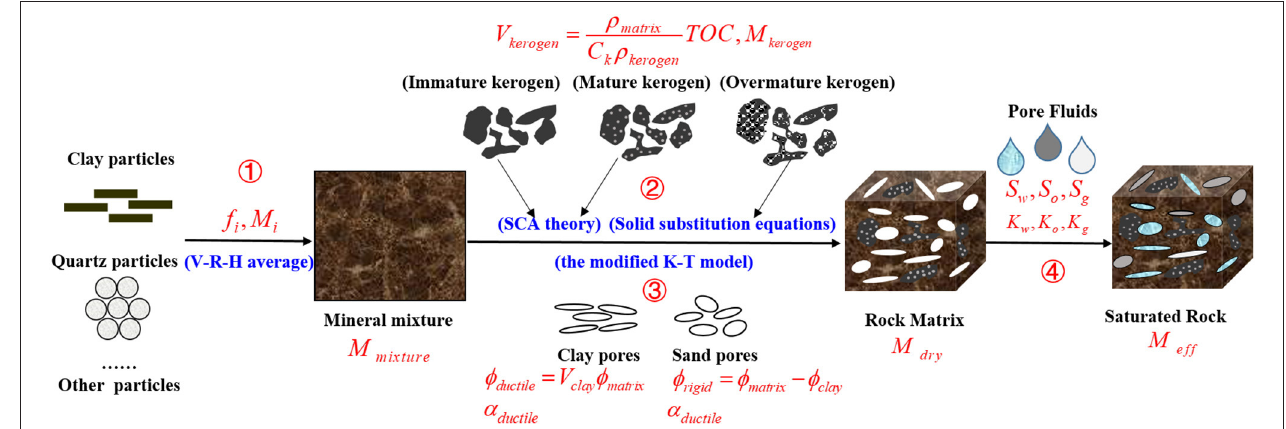
FIGURE 1 | Schematic diagram of rock physical modeling in the mud-rich source